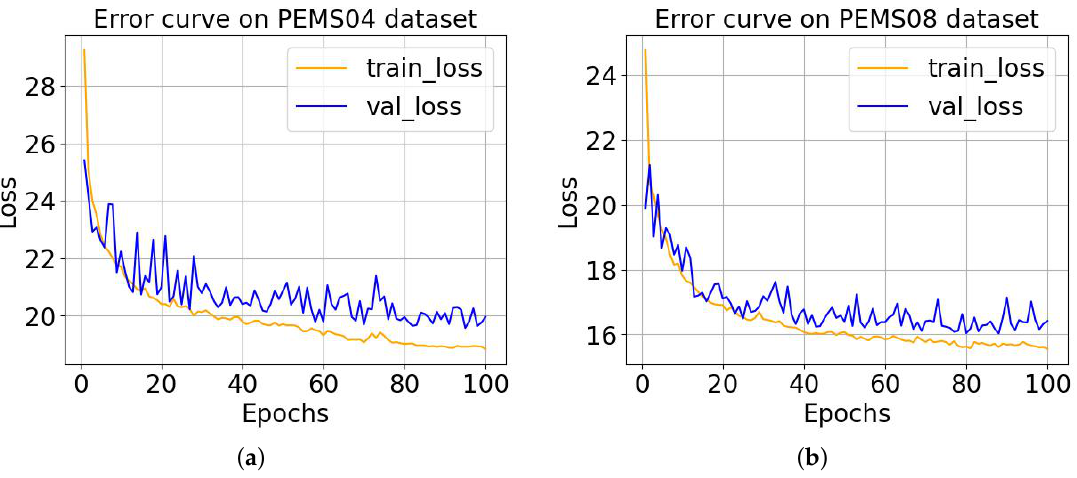
Figure 6. The training and validation error curves of the MD-GCN model on two datasets. ( a ) MD-GCN training and validating errors on the PEMS04 dataset; ( b ) MD-GCN training and validating errors on the PEMS08